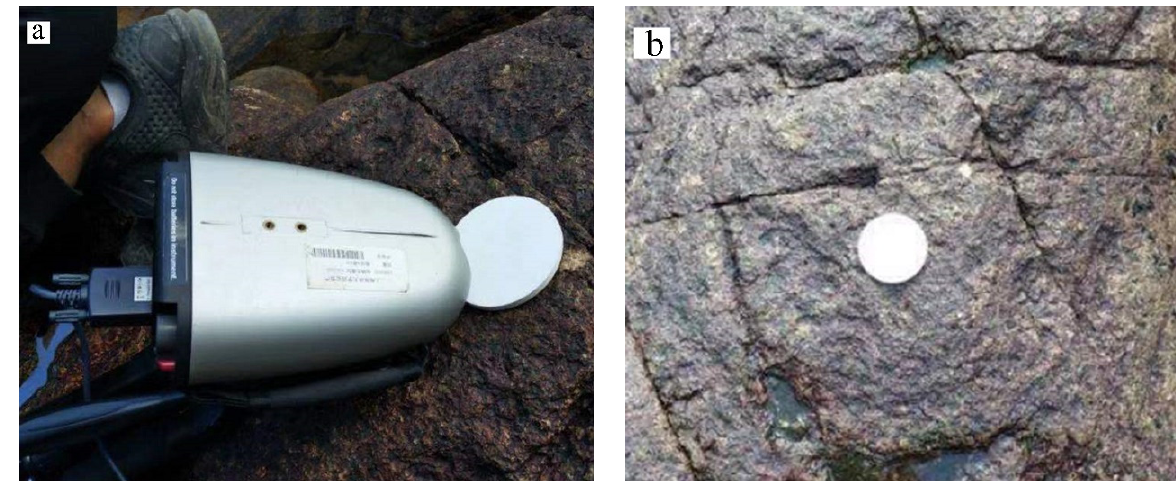
Figure 5. ASD spectrometer and calibration whiteboard. ( a ) is ASD spectrometer, ( b ) is calibration whiteboard.